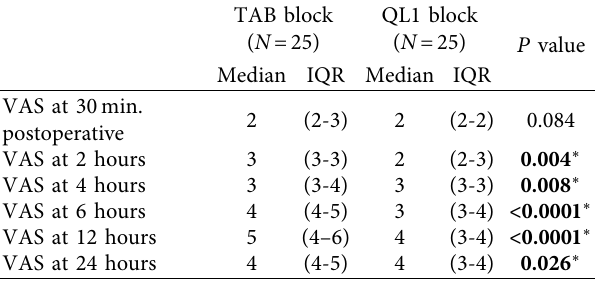
Table 3: VAS scores among different study